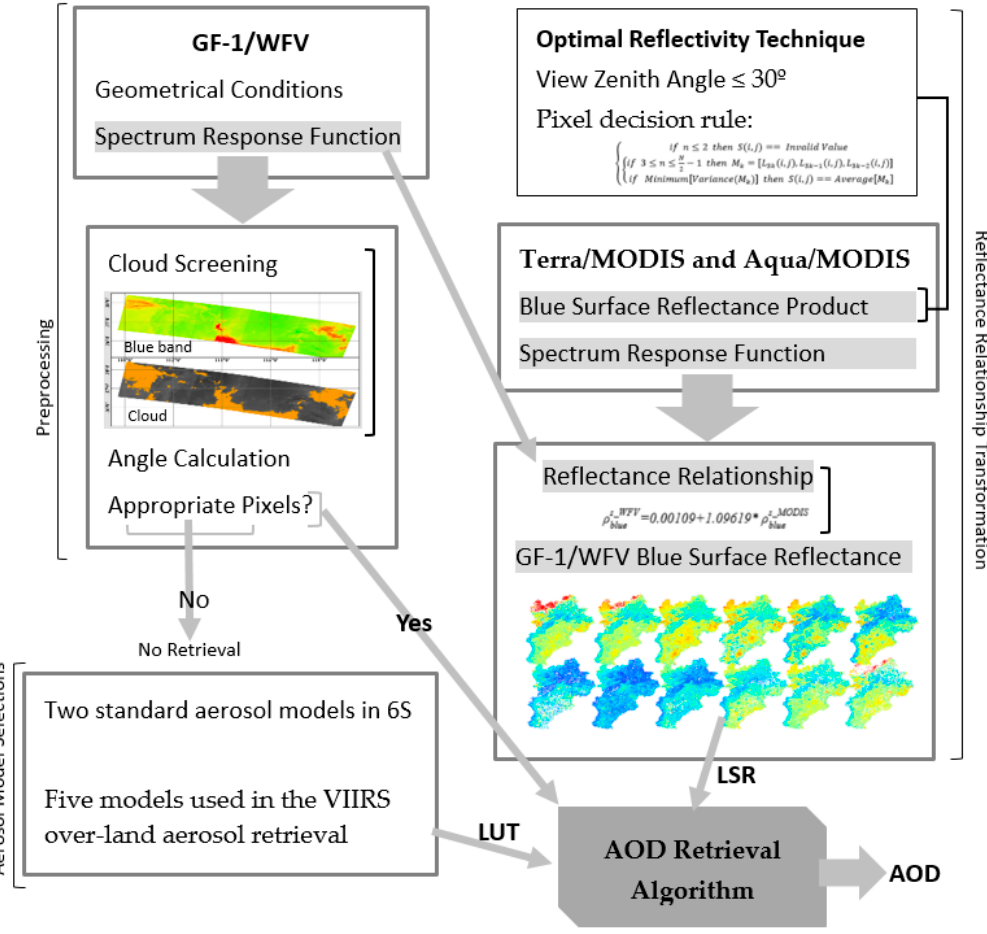
Figure 2. Flowchart for GF ‐ 1/WFV aerosol optical depth retrieval over land.